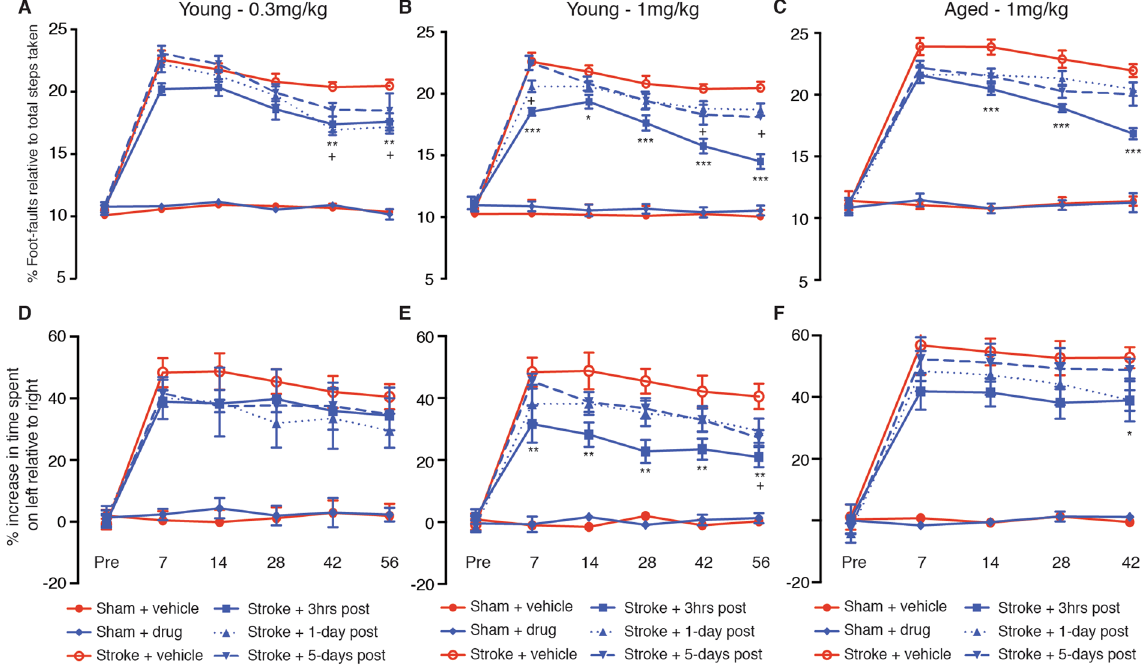
Figure 3. Behavioral recovery was assessed after stroke in young and aged mice. Behavioral recovery in young animals was assessed following 0.3 mg/kg and 1 mg/kg dosing of PEG-IGF-I on both the grid-walking ( A and B respectively) and cylinder/forelimb asymmetry ( D and E respectively) tasks. Behavioral recovery was also assessed in aged animals following 1 mg/kg dosing of PEG-IGF-I on both the grid-walking ( C ) and cylinder/forelimb asymmetry ( F ) tasks. An n = 10 per group were used for these studies. * P < 0.05, ** P < 0.01, *** P < 0.001: significance between stroke + vehicle and stroke + PEG-IGF-I-treated from 3 hrs; + P < 0.05: significance between stroke + vehicle and stroke + PEG-IGF-I-treated from